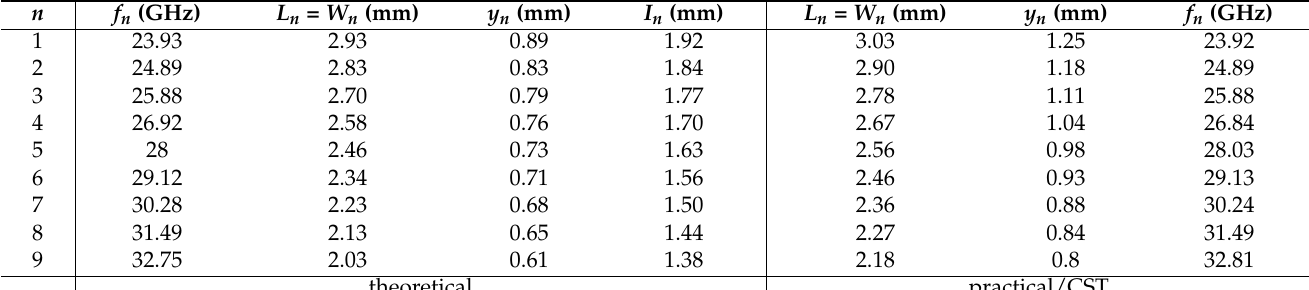
Table 1. Inset-fed microstrip antenna design parameters for a log-periodic structure with τ = 1.04.